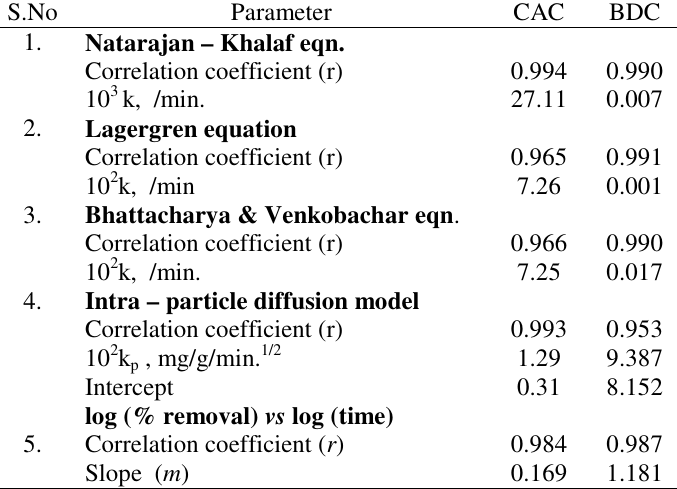
Table 3 . Kinetics of adsorption for removal of lead(II) ions by CAC and BDC at 30 °